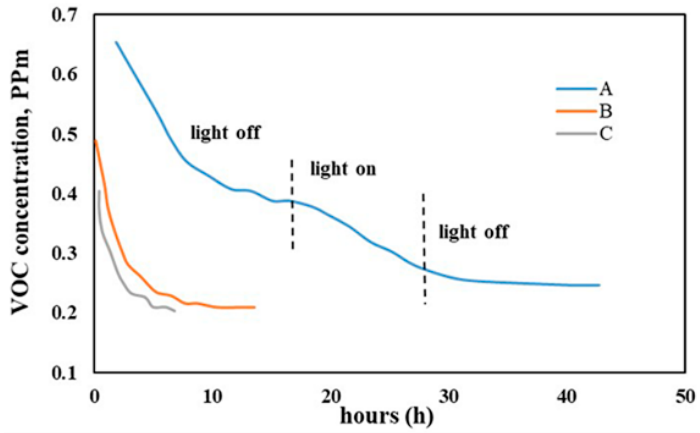
Figure 3. Formaldehyde concentration versus time. A—fan off. B—fan with airflow of 28.8 m 3 /h. C—fan with airflow of 82.8 m 3 /h, dehumidifier is off; vertical lines are the boundaries of lights on and off [137] .